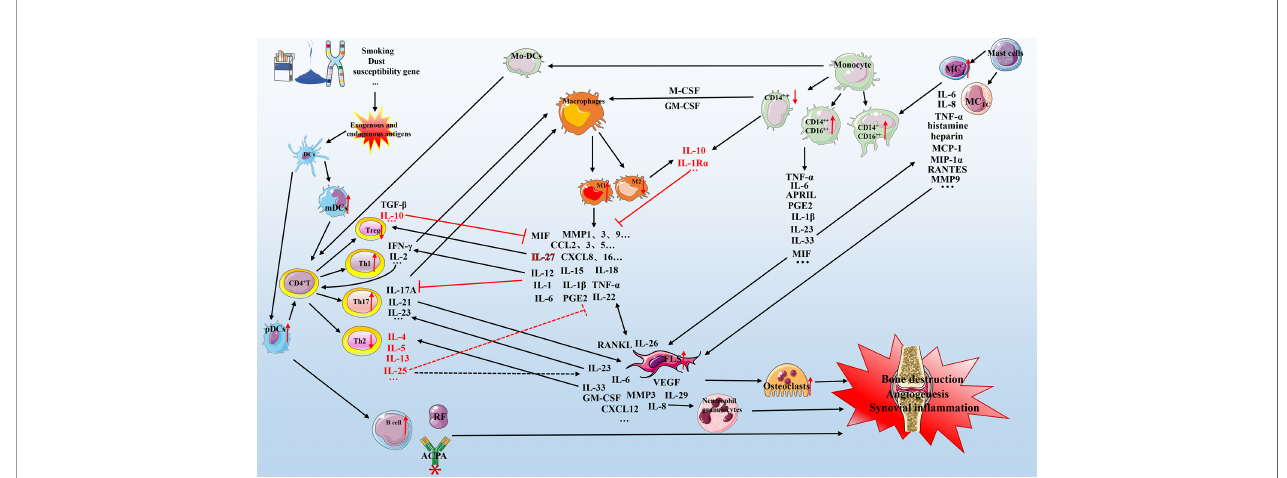
FIGURE 1 | Mechanism of cell-cytokine interaction in RA. Various factors (e.g., smoking, dust, genetic factors, and microorganisms) lead to the production of exogenous and endogenous antigens. Antigen-presenting cells (primarily dendritic cells) present exogenous and endogenous antigens to CD4+ T cells that differentiate into T cells with different functions, including Th1, Th2, and Th17. These cells cooperate with mast cells, macrophages, and monocytes to secrete multiple pro-in fl ammatory mediators that act on FLSs and osteoclasts, which in turn can secrete various biological mediators to aggravate the circulation. The anti- in fl ammatory mechanism (red represents anti-in fl ammatory mediators) is active but insuf fi cient to inhibit the pro-in fl ammatory process (black represents pro- in fl ammatory mediators). Brie fl y, the interaction of various cell subgroups and cell mediators forms a complex network that promotes the development of RA, including bone destruction, angiogenesis, and synovial in fl ammation. DC, dendritic cells; IL, interleukin; TNF- a , tumor necrosis factor- a ; mDCs, myeloid DCs; pDCs, plasmacytoid DCs; GM-CSF, granulocyte-macrophage colony-stimulating factor; M-CSF, macrophage colony-stimulating factor; CXCL, chemokine CXC ligand; CCL, CC-chemokine ligand; MMP, matrix metalloproteinase; MCP-1, monocyte chemoattractant protein-1; PGE2, prostaglandin E2; APRIL, a proliferation-inducing ligand; RF, rheumatoid factor; ACPA, anti-citrullinated protein antibody; FLS, fi broblast-like synoviocyte; TGF, transforming growth factor; VEGF, vascular endothelial growth factor; MC, mast